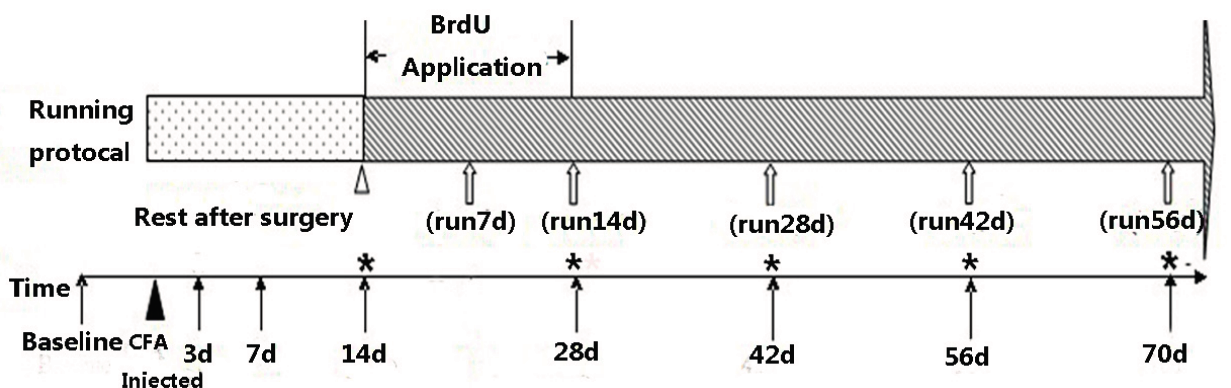
Figure 5. Time course of the experimental protocol indicates the time point of the complete Freund’s Adjuvant (CFA) injection. indicates the starting time of the daily running exercise and the BrdU application. indicates the time points of the hindpaw withdrawal mechanical threshold measurements. indicates the time points of